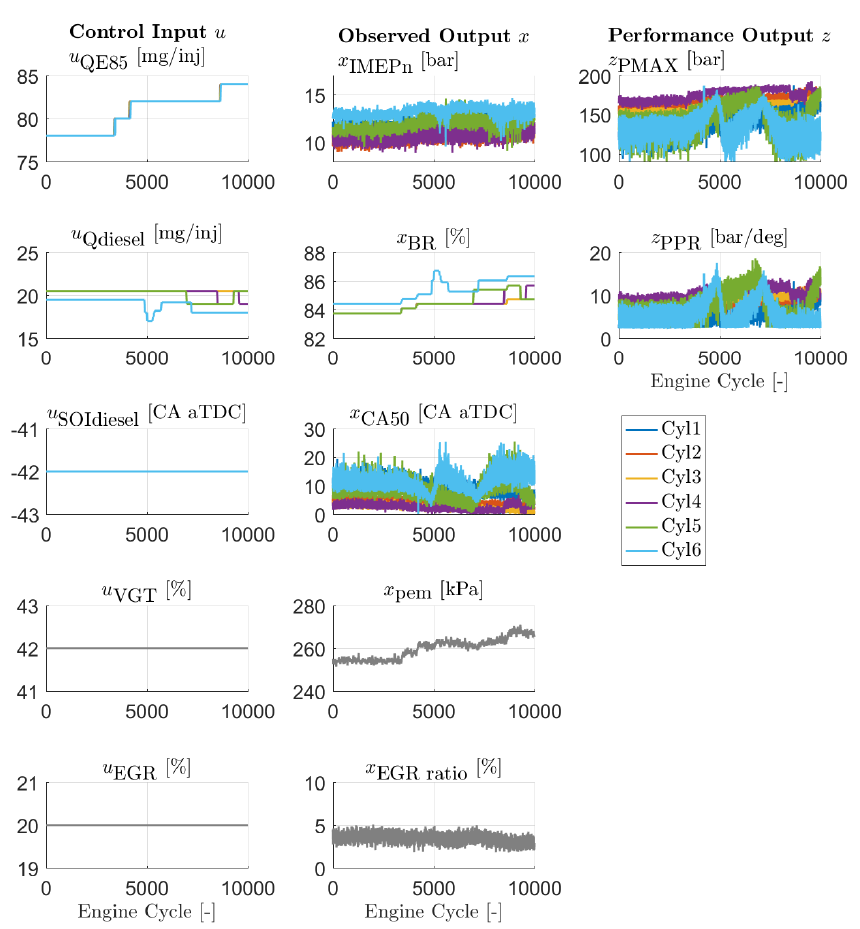
Figure A3. Engine load increase with open-loop RCCI engine control at ω e = 1000 rpm